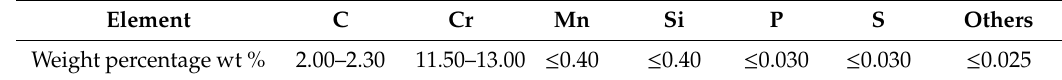
Table 1. Chemical composition of210Cr12